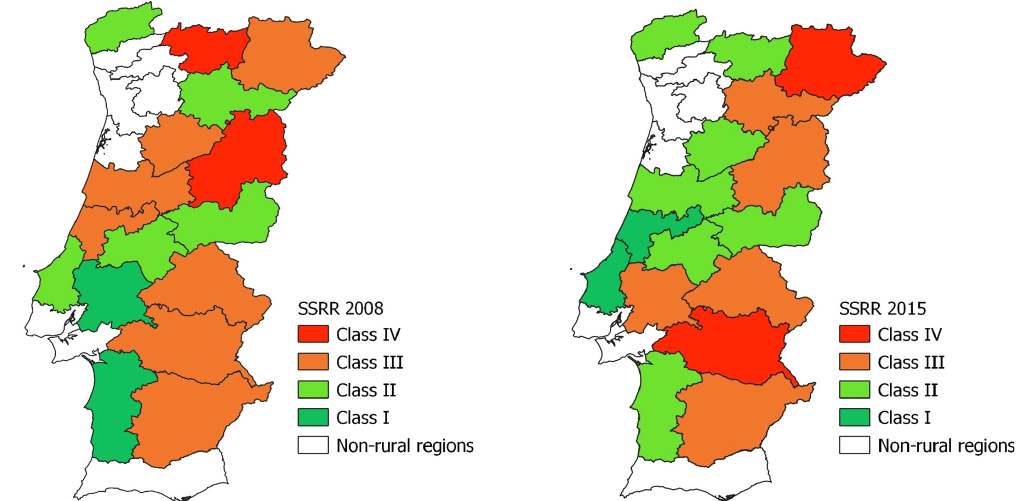
Fig. 3. Classification of rural regions based on SSRR index for Portugal in 2008 and 2015. Source: own calculations using data from